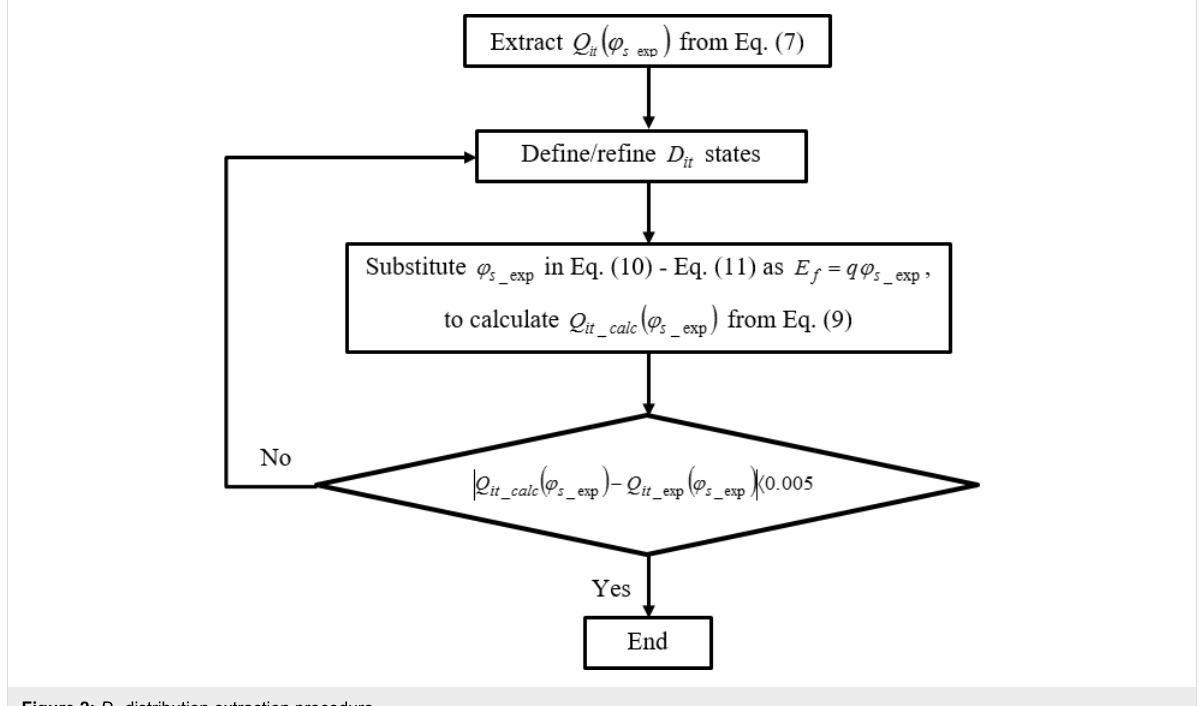
Figure 2: D it distribution extraction